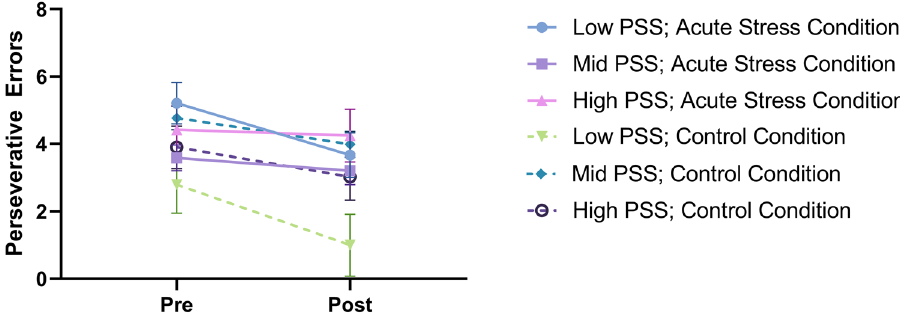
Figure 2. Number of perseverative errors for high, medium, and low perceived chronic stress groups across the acute stress and control conditions; error bars = standard error; dashed line = control condition; figure includes all participants (n control = 51, n stress =